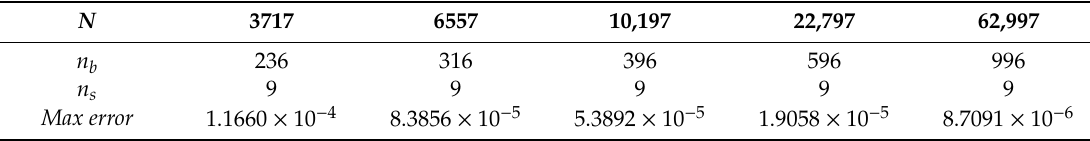
Table 1. The maximum absolute error for Case 1.